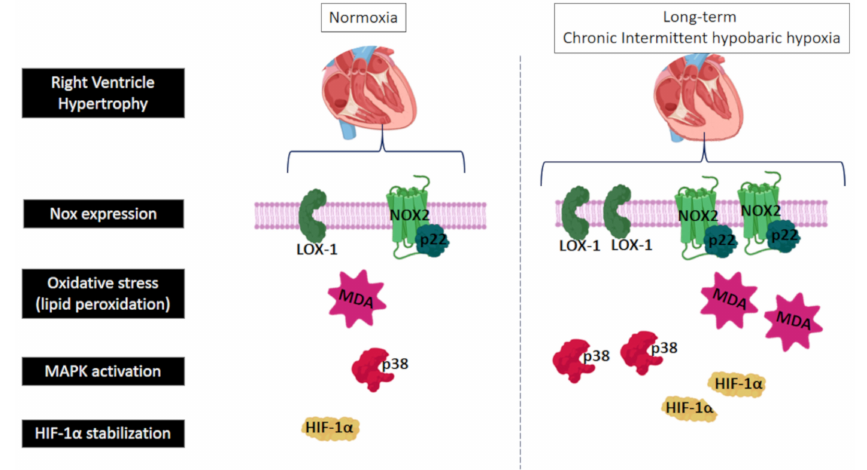
Figure 5. Schematic diagram of the main results and the proposed signaling pathway implicated in the development of right ventricle hypertrophy (RVH) induced by long-term intermittent hypobaric hypoxia; LOX-1: lectin-like oxidized low-density lipoprotein receptor-1; Nox2: nicotinamide adenine dinucleotide phosphate oxidase-2; p22: p22phox subunit of NADPH-oxidases; MDA: malondialdehyde; HIF-1 α : hypoxia-inducible factor-1 α , and p38 α : mitogen-activated protein kinase p38 α